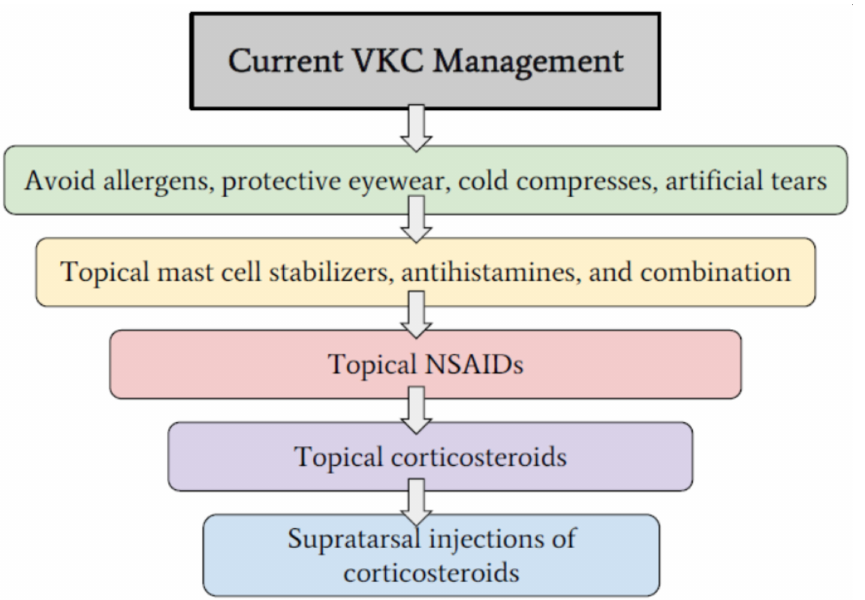
Figure 1. Breakdown of current stepwise approach to the clinical management of VKC and allergic ocular conditions.